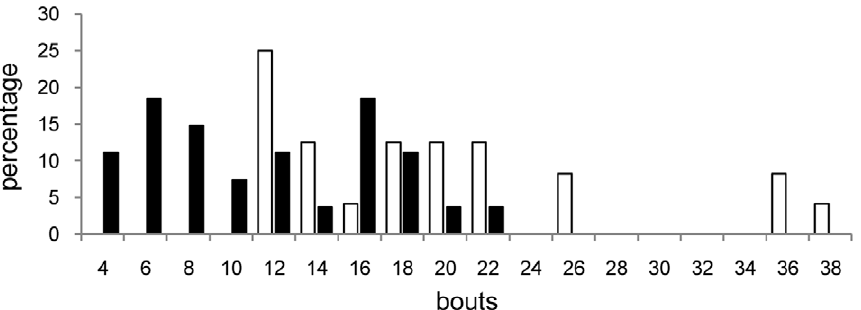
Figure 2. Distribution of number of bouts needed to pass the learning task as a function of diet. (White boxes–LO diet birds(mean 6 S.E.:20.32 6 1.57); black boxes–HI diet birds (mean 6 S.E.: 12.03 6 1.06). (For statistical effect, see Tables 3 and 4.)